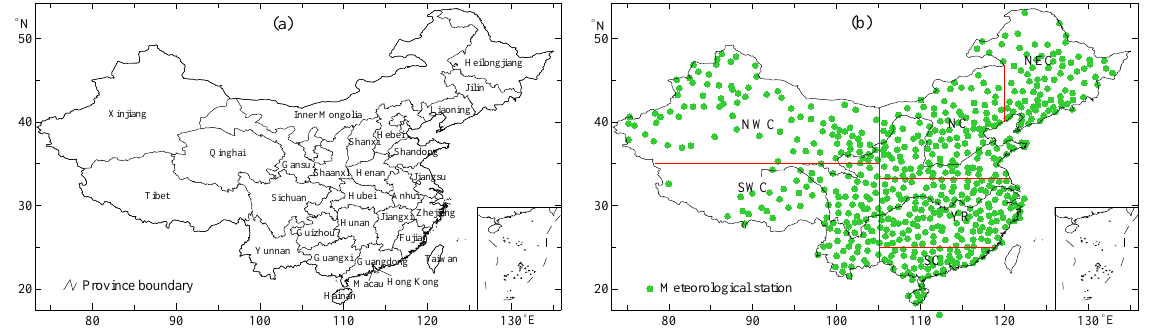
Figure 1. The administrative division (a) and spatial distribution of meteorological stations and regions of China (b) . China is divided into six regions, namely, Northeast China (NEC), North China (NC), the mid–lower Yangtze River valley (YR), South China (SC), Northwest China (NWC) and Southwest China (SWC). Table 1. Linear trends of annual average spells of high-impact weather in China during 1959–2014 (unit: times decade − 1 ). Regions of China High-impact weather NEC NC YR SC NWC SWC Snowfall spells − 0.396 − 0.304 − 0.135 − 0.436 Thunderstorm spells − 0.285 − 0.360 − 0.584 Foggy spells − 0.075 Hailstorm